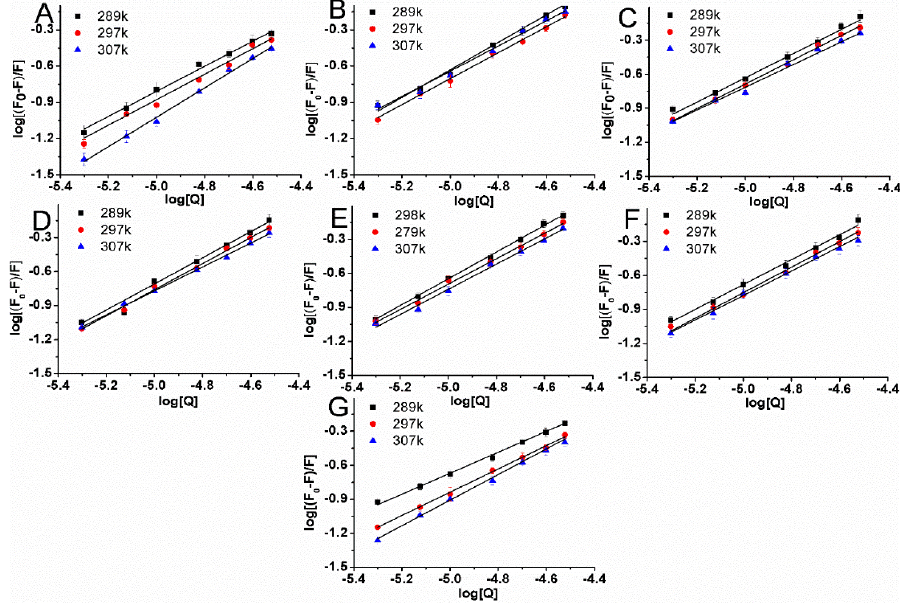
Figure 5. Plots of Log [(F 0 − F)/F] vs. Log [Q] for BSA (5 µ M) quenched by compounds 1 ( A ), 2 ( B ), 3 ( C ), 4 ( D ), 5 ( E ), 6 ( F ), and 7 ( G ) at different temperatures in 0.05 mol L − 1 Tris-HCl, pH 7.4. The concentrations of compounds varied from 0 to 30 µ